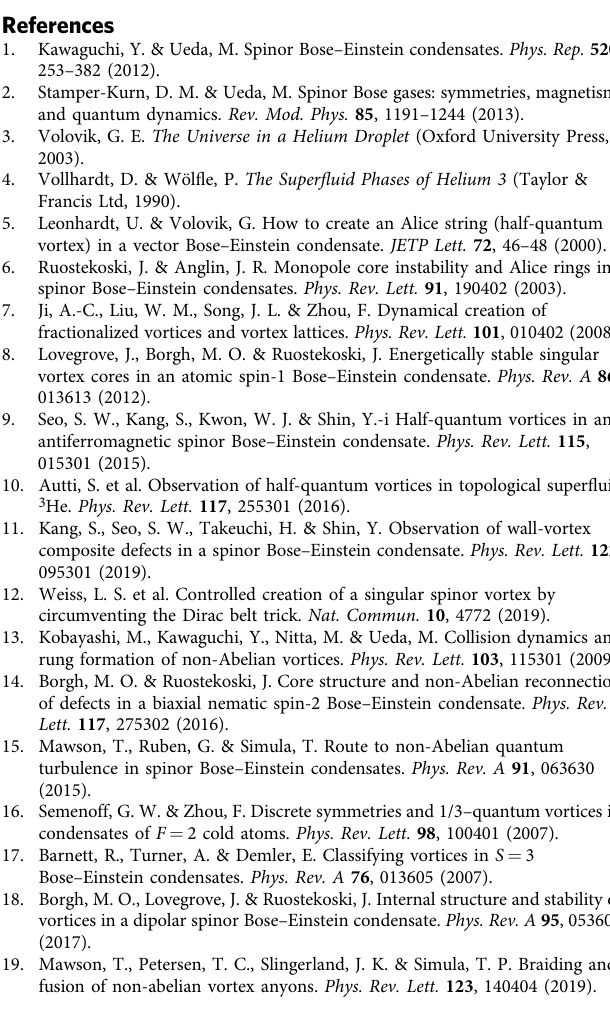
Figs. 1 – 6 are provided as a Source data fi le in the Zenodo repository (doi:10.5281/ zenodo.4384683) (ref. 61 ). Code